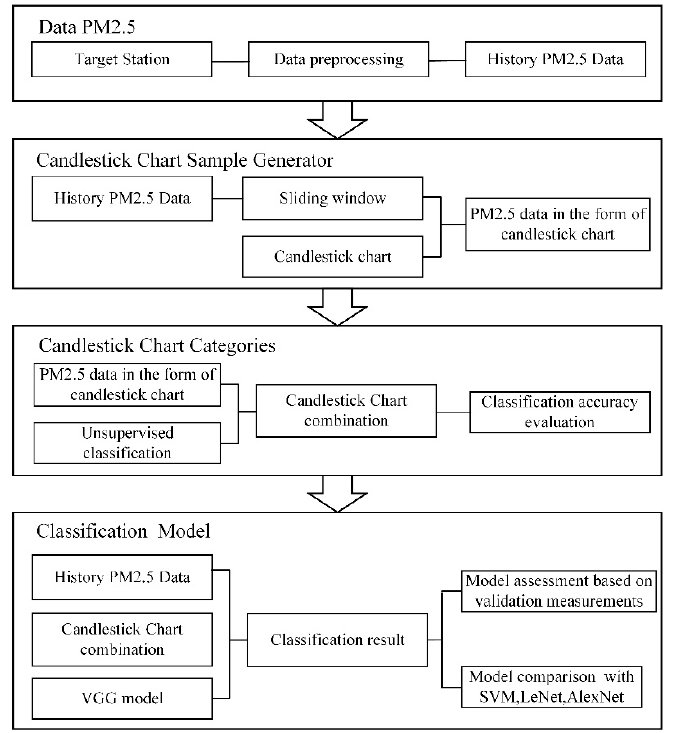
Figure 5. PM 2.5 data classification framework.